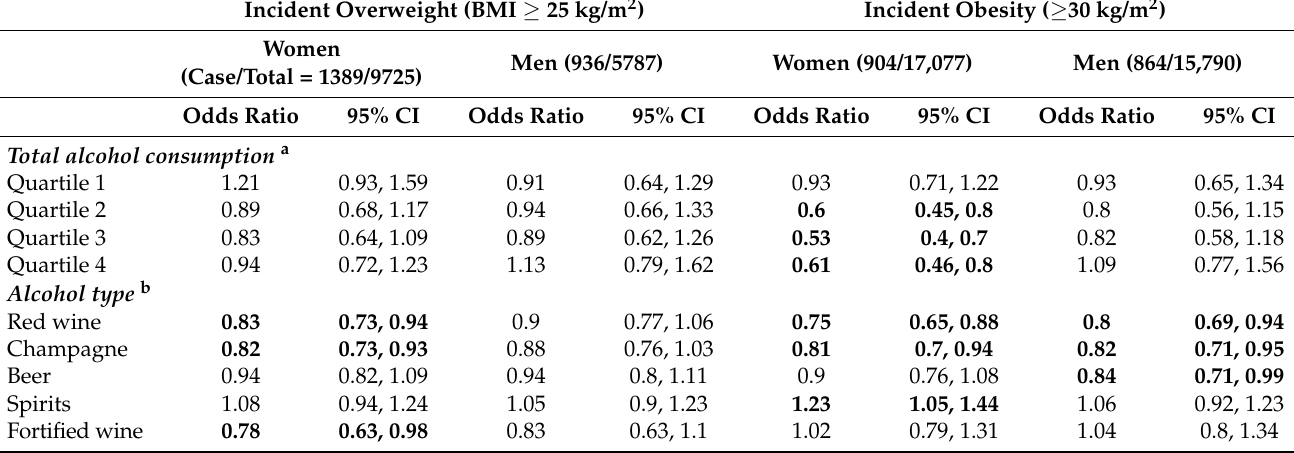
Table 4. The associations of total alcohol consumption and individual type of alcoholic drink